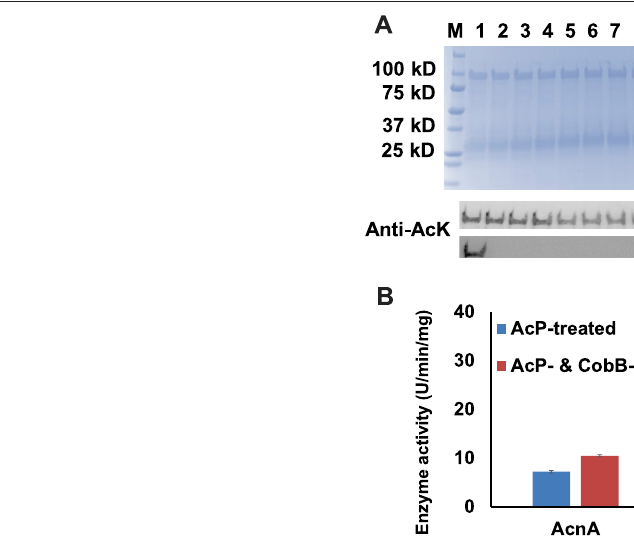
Frontiers in Chemistry |